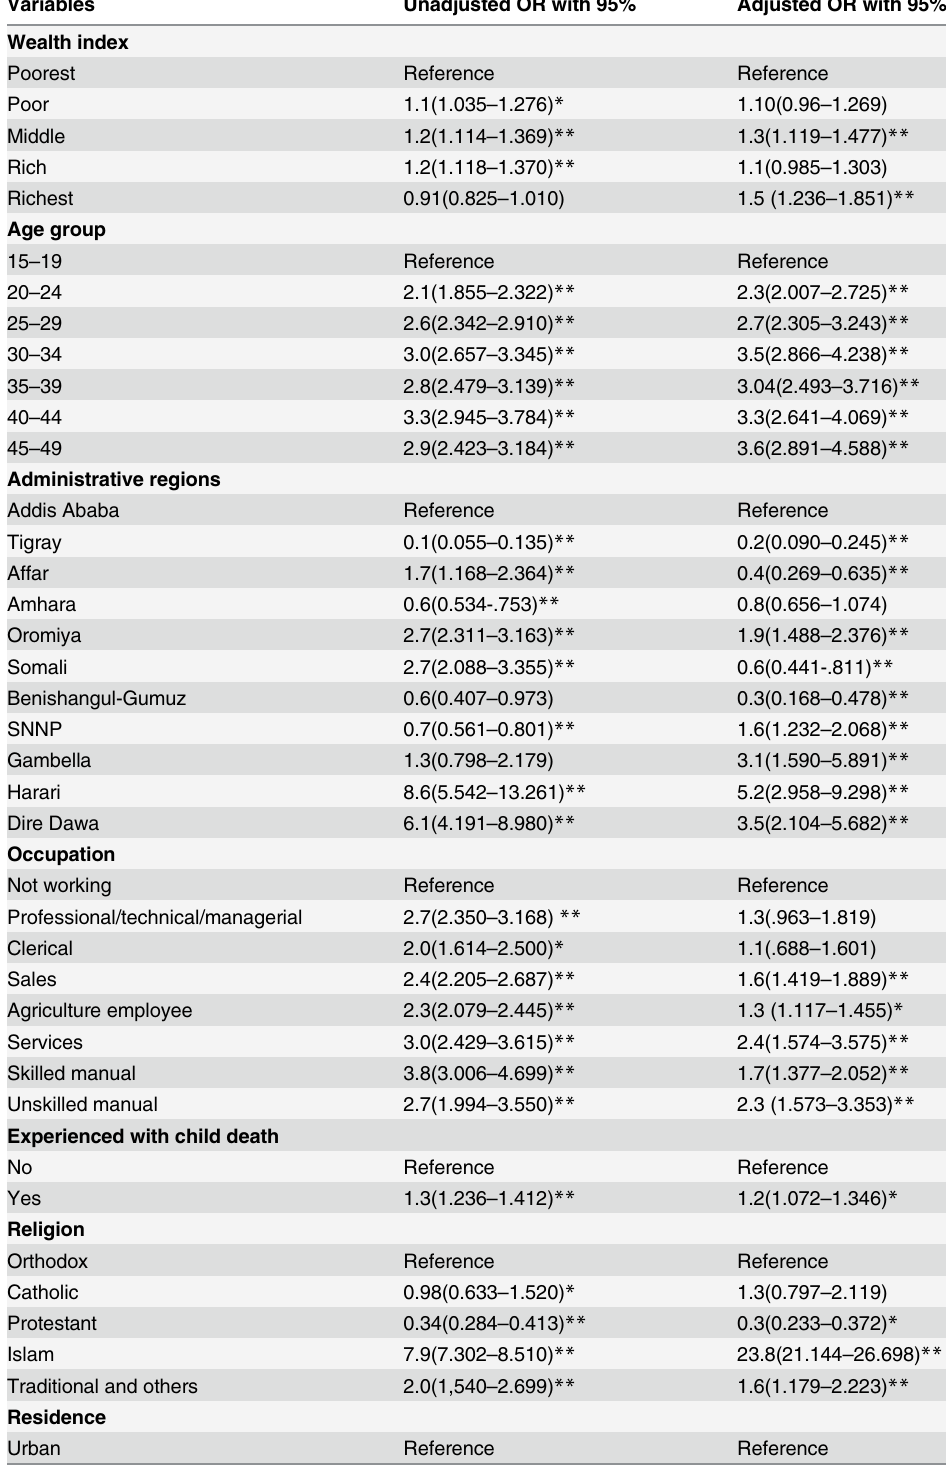
Table 2. Bivariate and multivariate logistic regression analysis showing factors associated with khat chewing practice among adult population in Ethiopia,